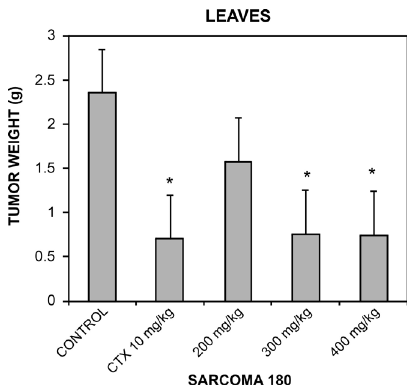
FIGURE 1 – Mean tumor weight. *p < 0.05 comparing treated groups with control group ( normal saline solution). Student’s t test (n =